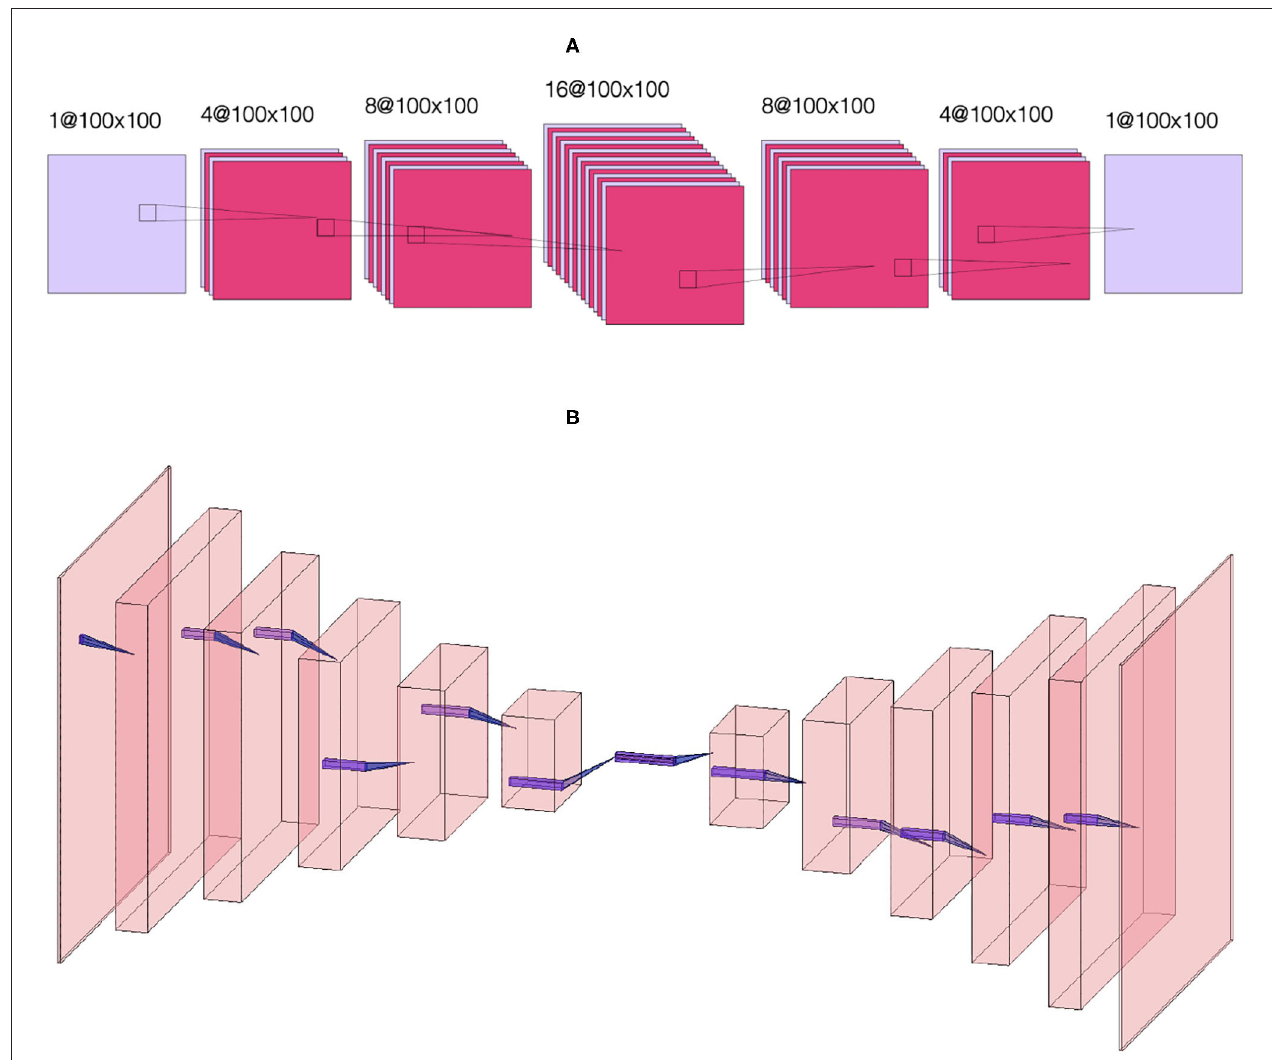
N image and applies four 3 N 3 convolutions to generate four N × × × N images, the third layer applies 16 3 N 3 convolutions to generate sixteen N × × × N images, the fifth layer applies four 3 N images 3 convolutions to generate four N × × × N image. Sketch of (B) autoencoder NN 2. The first six layers perform a meanpool operation × 100 2 ,50 2 ,25 2 ,12 2 ,6 2 ,3 2 ,1 2 while adding channels { }